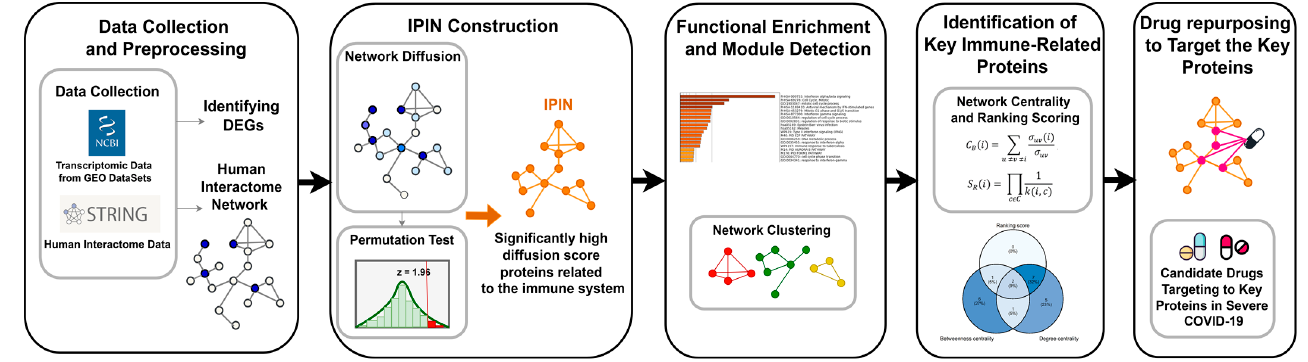
Figure 1. Summary of the process to identify the key proteins and drug repurposing in the severe COVID-19 based on an immune-related protein interaction network (IPIN). Circles represent protein nodes in a protein-protein interaction network. Dark blue circles are nodes of the DEGs’ proteins. Light blue circles are nodes of proteins having diffuse scores. Orange circles represent high diffusion score proteins for IPIN. Red, green, and yellow circles are proteins in different modules. Pink circles are target proteins of an existing